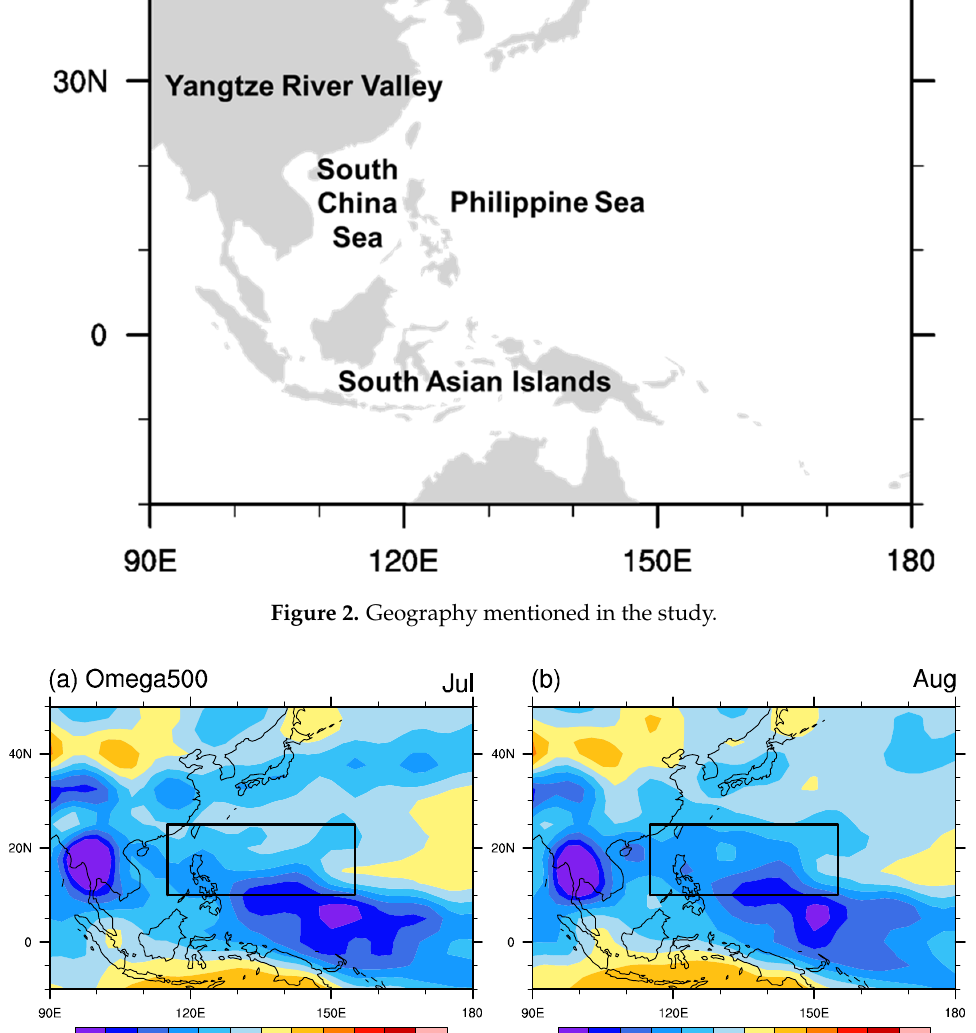
Figure 3. Climatology of the vertical velocity at 500-hPa in ( a ) July and ( b ) August (units: Pa/s). The black box denotes the region mainly focused on in this study (10–25° N, 115–155° E).